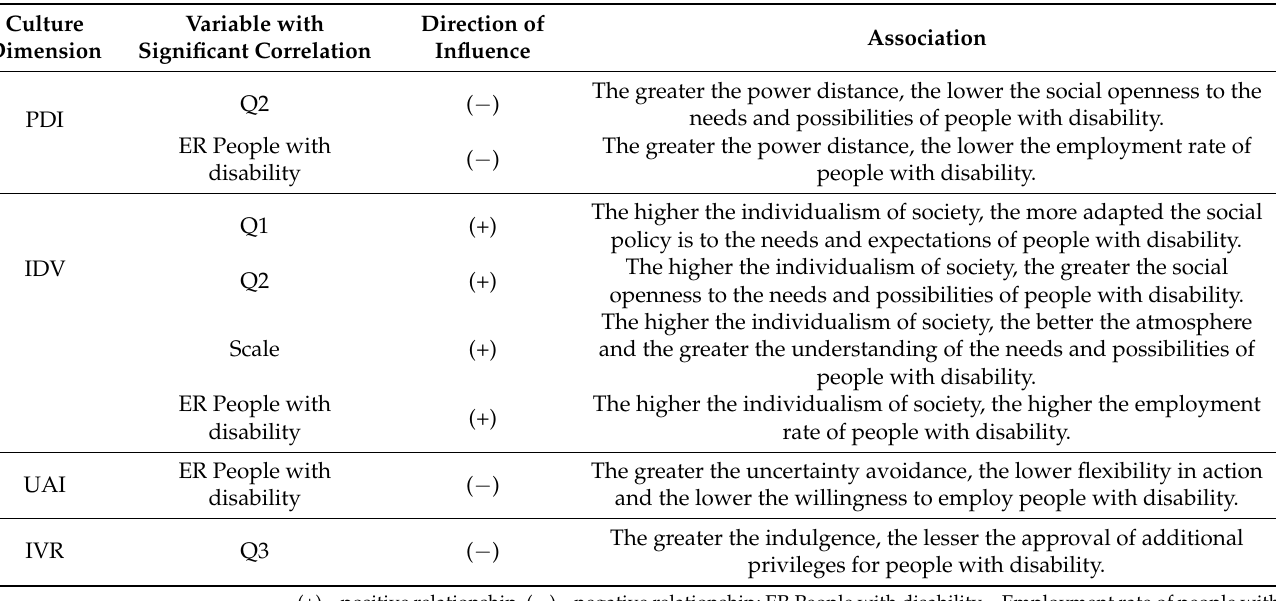
Table 2. The significance of culture dimensions in the perception of people with disability in the workplace and in their